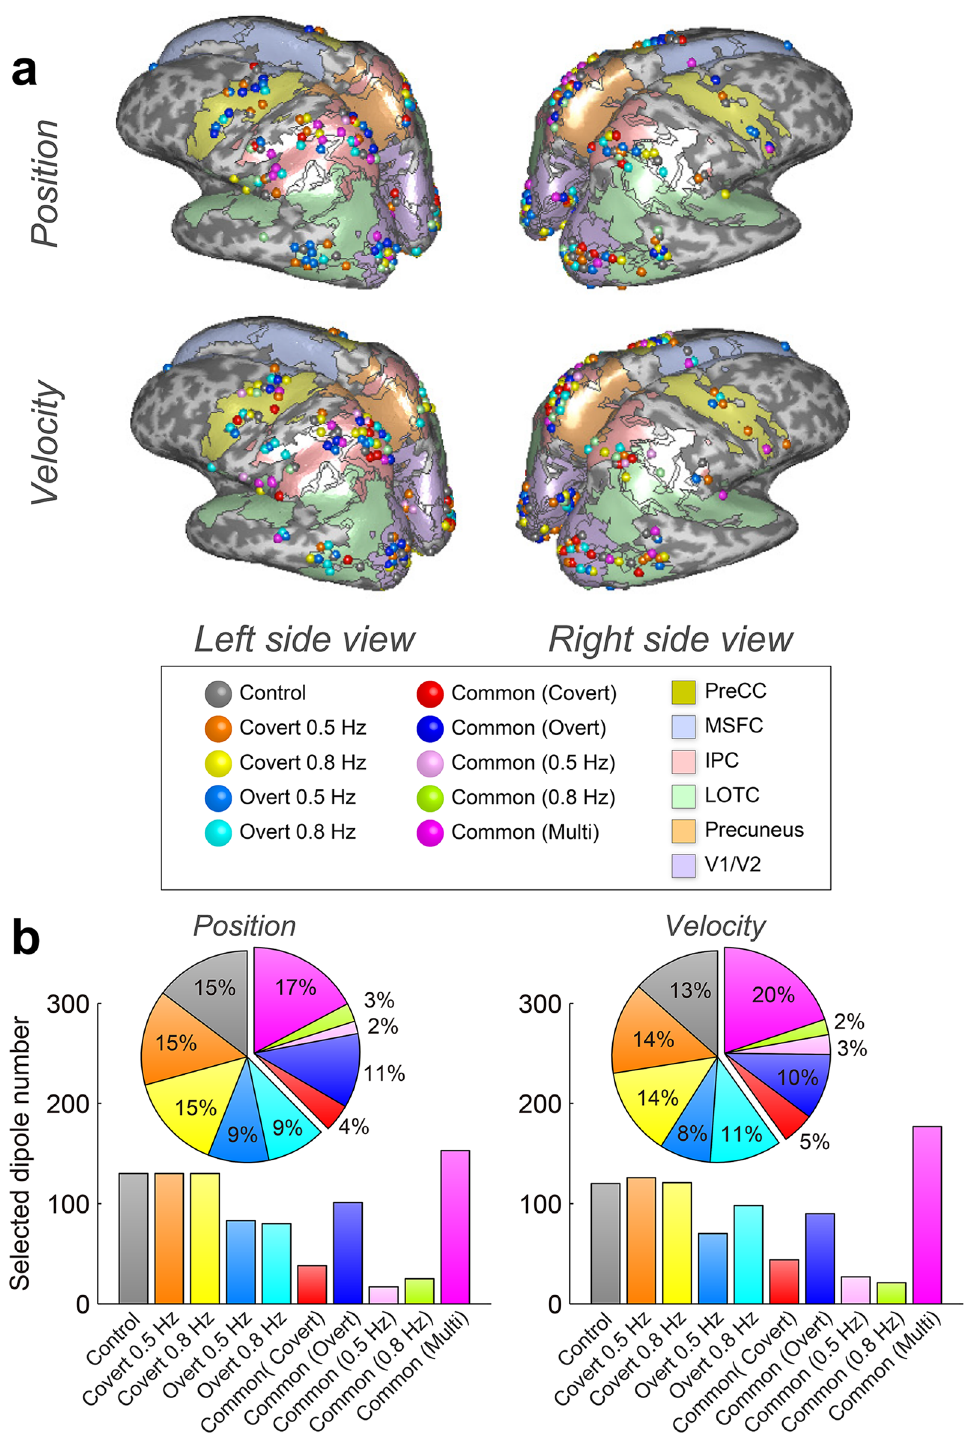
Figure 6. ( a ) SLiR–selected dipole locations on inflated cortical surface maps. ( b ) Rate of selected dipole numbers for tasks. The exclusively selected dipoles for control, covert 0.5 Hz, covert 0.8 Hz, overt 0.5 Hz, and overt 0.8 Hz are shown in gray, orange, yellow, blue, and cyan, respectively. The commonly selected dipoles for covert (0.5 and 0.8 Hz), overt (0.5 and 0.8 Hz), 0.5 Hz (covert and overt), and 0.8 Hz (covert and overt) are shown in red, blue-purple, pink, and green, respectively. The commonly selected dipoles by more than three tasks are shown in magenta. The same color format is used in pie charts and bar graphs in ( b ). Numbers of cortical dipole currents were 1987.17 ± 2057.03 (participant mean ± SD), and these dipole currents were used for SLiR inputs as explanatory variables. Input dimensions of control, covert 0.5 Hz, covert 0.8 Hz, overt 0.5 Hz, and overt 0.8 Hz were reduced to 55.17 ± 15.15, 62.47 ± 18.77, 55.53 ± 18.54, 64.50 ± 19.79, and 68.57 ± 20.15 [position] and 56.90 ± 16.67, 64.93 ± 17.79, 56.50 ± 14.44, 61.07 ± 25.72, and 69.07 ± 19.02 [velocity]. Cortical regions of PreCC, MSFC, LOTC, IPC, precuneus, and V1/V2 had current dipole numbers of 141.33 ± 127.20, 59.33 ± 64.35, 335.50 ± 364.52, 314.83 ± 283.26, 26.50 ± 34.80, and 529.50 ± 583.36, respectively. SLiR sparseness narrowed input dimensions to [position]: 4.83 ± 1.60, 2.50 ± 3.99, 7.00 ± 4.34, 10.50 ± 7.12, 0.67 ± 0.82, and 16.33 ± 10.80, [velocity]: 6.33 ± 3.22, 3.33 ± 4.80, 8.33 ± 7.55, 9.83 ± 6.91, 0.33 ± 0.52, and 13.17 ± 7.22,